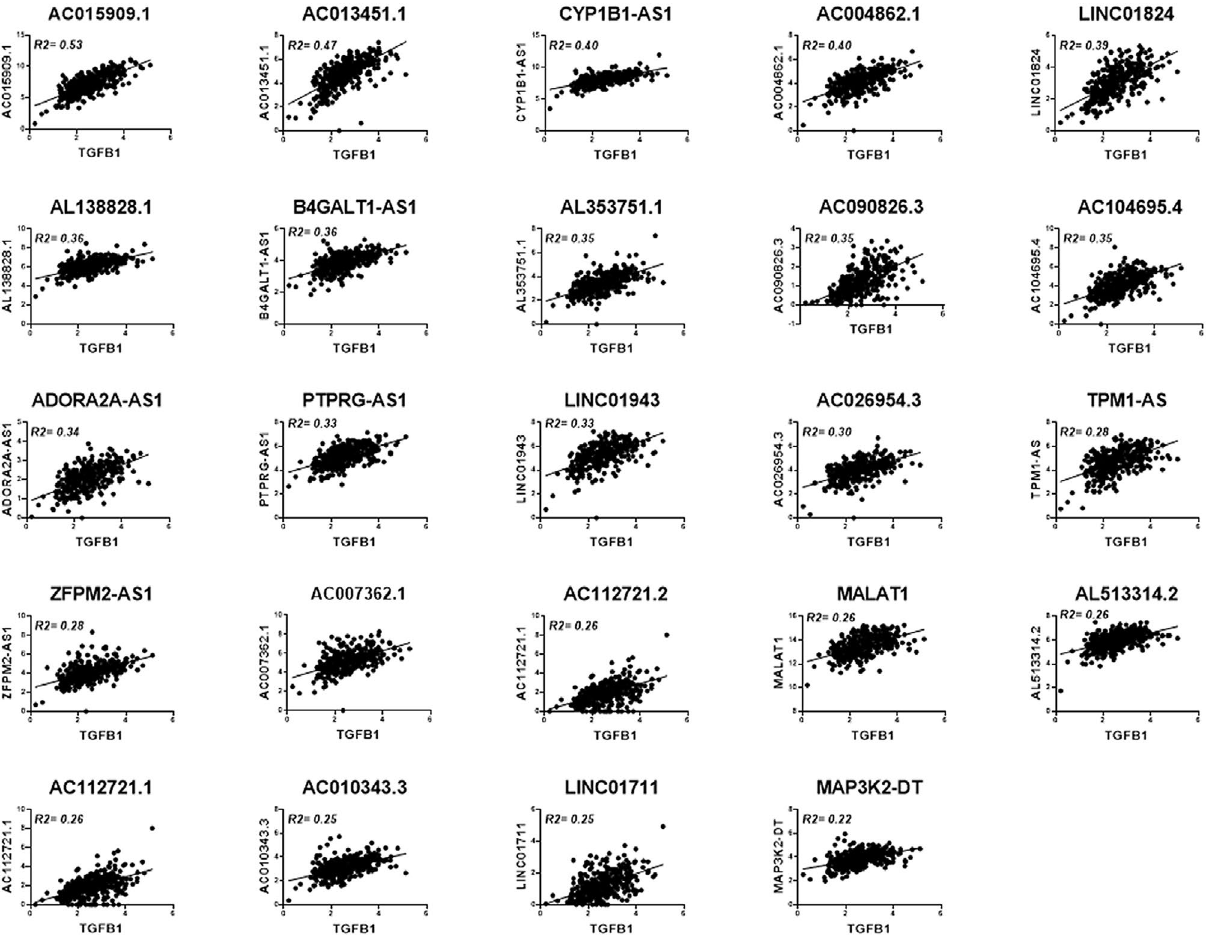
Figure 5. Dot plot depicting the correlation between the expression of TGFB1 and the indicated lncRNAs in a cohort of 360 TNBC